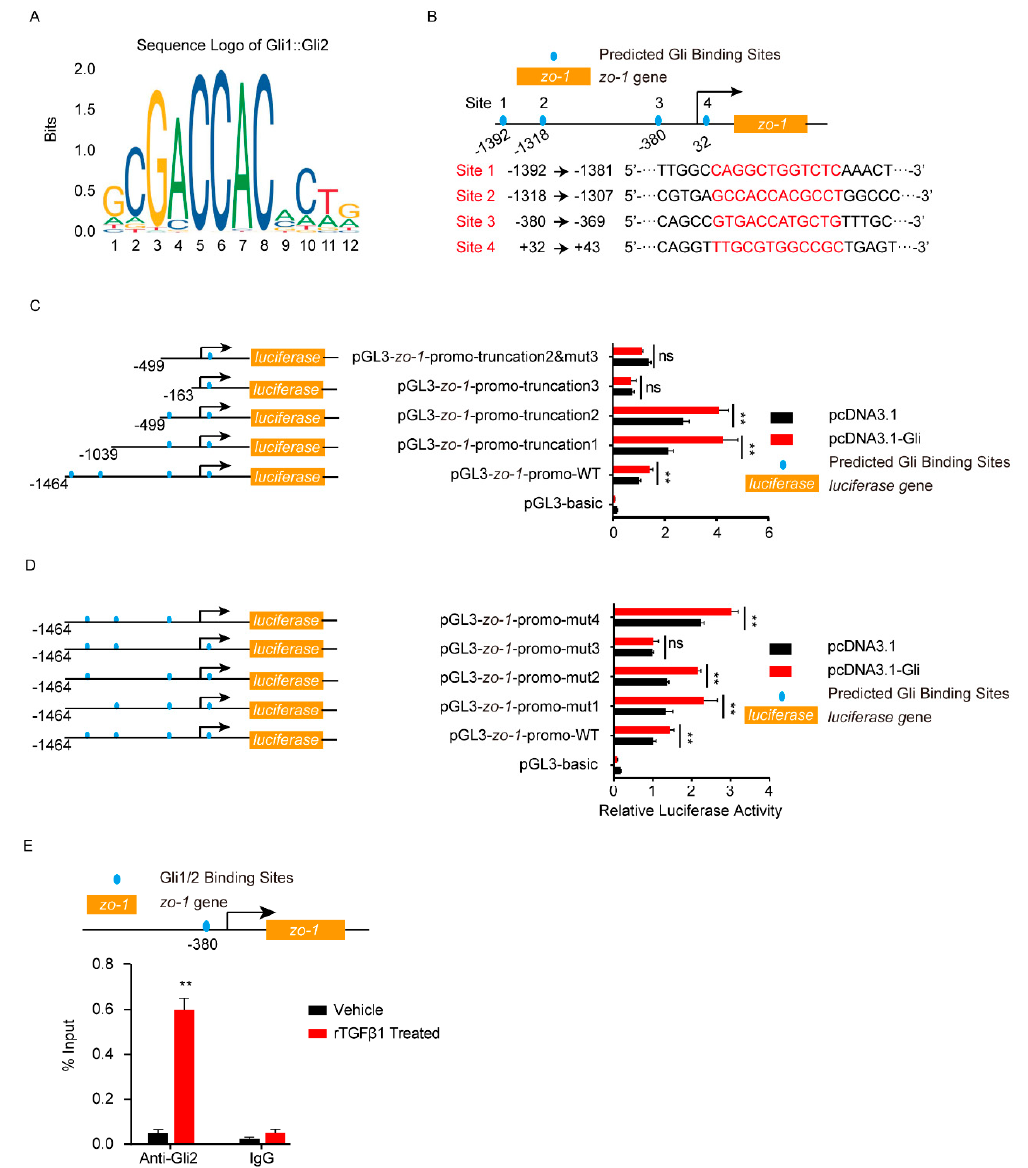
Figure 6. Analysis of Gli1/2 binding sites on zo-1 promotor by dual-luciferase reporter assays. ( A ) The sequence logo of the Gli1/2 binding motif. ( B ) Schematic of the 4 predicted Gli1/2 binding sites on zo-1 promotor and their binding sequences accordingly. The binding sites were located at − 1392 to − 1381 (site 1), − 1318 to − 1307 (site 2), − 380 to − 369 (site 3), and +32 to +43 (site 4) of the zo-1 promotor. ( C , D ) The zo-1 luciferase activities tested by applying a series of truncations ( C ) and site-targeted mutations ( D ) to the zo-1 promoter, along with pcDNA3.1-Gli1, pcDNA3.1-Gli2, and pRL-TK plasmids. The specific constructs used in the truncation assays ( C ) included pGL3-basic vector, pGL3- zo-1 -promo-WT (containing promotor region from − 1464 to +167), pGL3- zo-1 -promo-truncation1 (from − 1039 to +167), pGL3- zo-1 -promo-truncation2 (from − 499 to +167), pGL3- zo-1 -promo-truncation3 (from − 163 to +167), and pGL3- zo-1 -promo-truncation2&mut3 (from − 499 to +167 which lacking site 3). The specific constructs used in the site-mutation assays ( D ) included pGL3-basic vector, pGL3- zo-1 -promo-WT (containing all 4 sites), pGL3- zo-1 -promo-mut1 (lack of site 1), pGL3- zo-1 -promo-mut2 (lack of site 2), pGL3- zo-1 -promo-mut3 (lack of site 3), and pGL3- zo-1 -promo-mut4 (lack of site 4). The luciferase activities were determined, and are presented as the ratios of firefly luciferase activity and renilla luciferase activity. The assays were performed with 3 replicates, and data are presented as mean ± SEM. ** p < 0.01. ns, no significance. ( E ) ChIP-qPCR validation of the Gli1/2 binding to the zo-1 promotor around − 380 in hBMECs treated by TGF β 1 (50 ng/mL). ChIP was performed with anti-Gli2 antibody, and rabbit IgG was used as the negative control. ** p < 0.01. The assays were performed with at least 3 replicates, and data were presented as mean ± SEM.